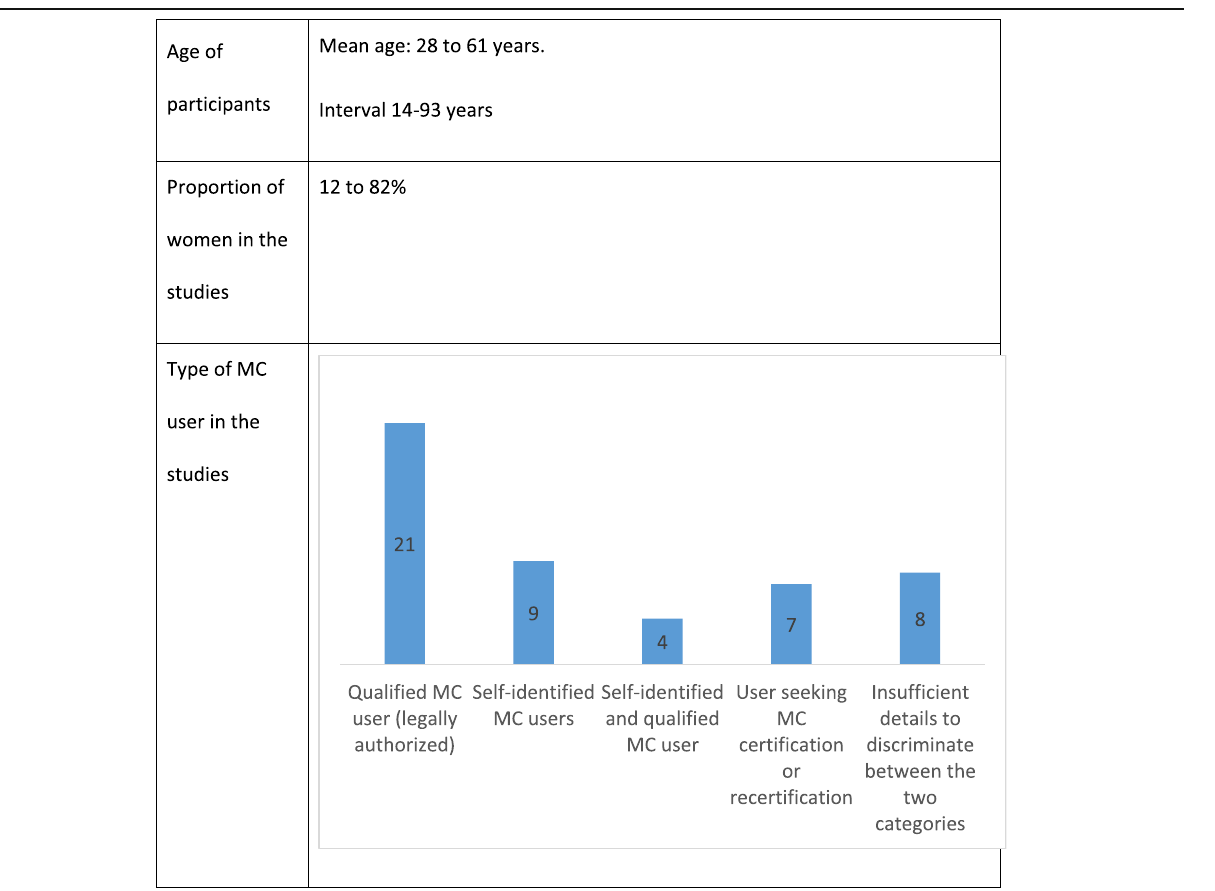
Table 4 Patients ’